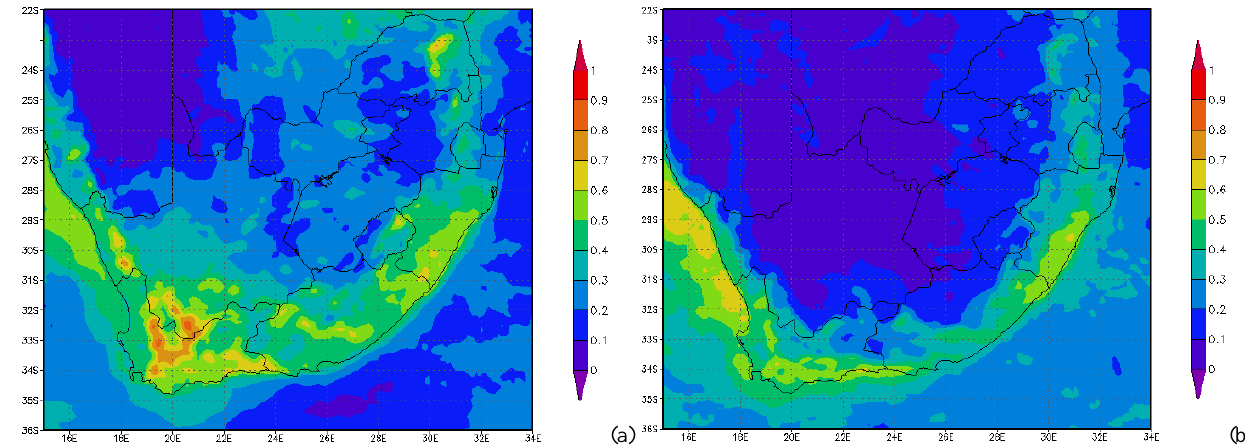
Fig. 7. Ratio of UM stratiform rainfall over UM Total rainfall for winter months (a) and summer months (b) for 2008 and 2009.